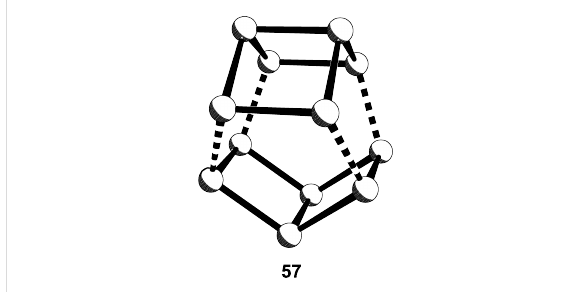
Figure 5: Coupling of two Dewar benzenes.